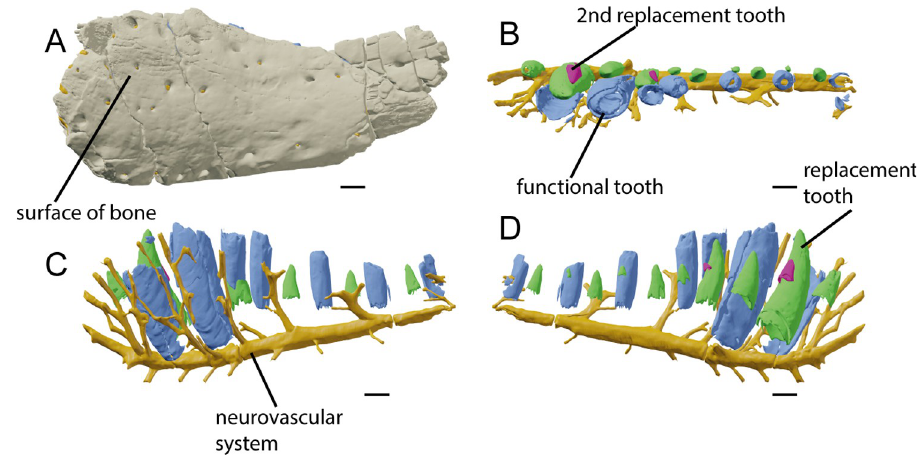
Fig 4. CT-scan of the holotype of Iberospinus natarioi (ML1190-1). A , Surface of the bone and the foramina in lateral view; B , Neurovascular system, teeth and replacement teeth in occlusal view; C , Neurovascular system, teeth and replacement teeth in lateral view; D , Neurovascular system, teeth and replacement teeth in occlusal view. Scale bar is 10 mm. Voxel size of the model: 0.100628. Grey , dentary bone, Yellow , neurovascular system, Blue , teeth, Green , first replacement teeth, Pink , second replacement teeth.